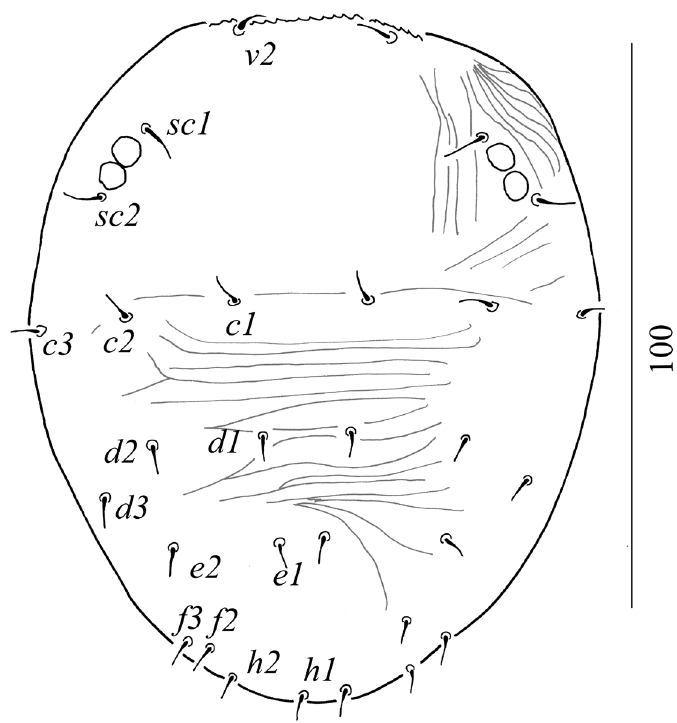
Figure 22. Dorsal view of Aegyptobia bozaii sp. n., paratype,